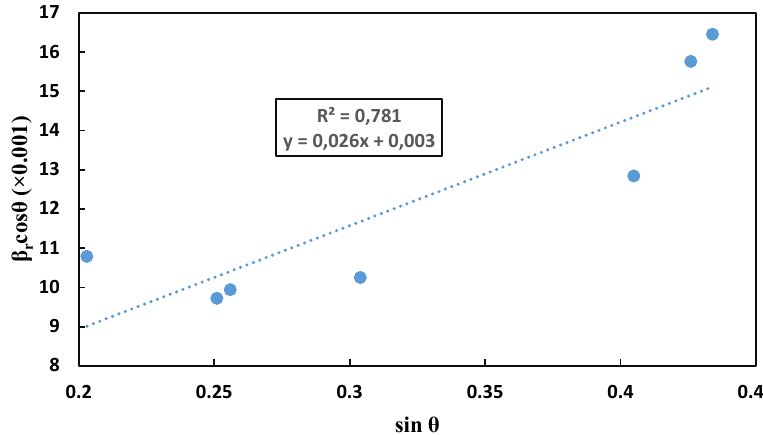
Fig. 2. Williamson-Hall plot of CdWO